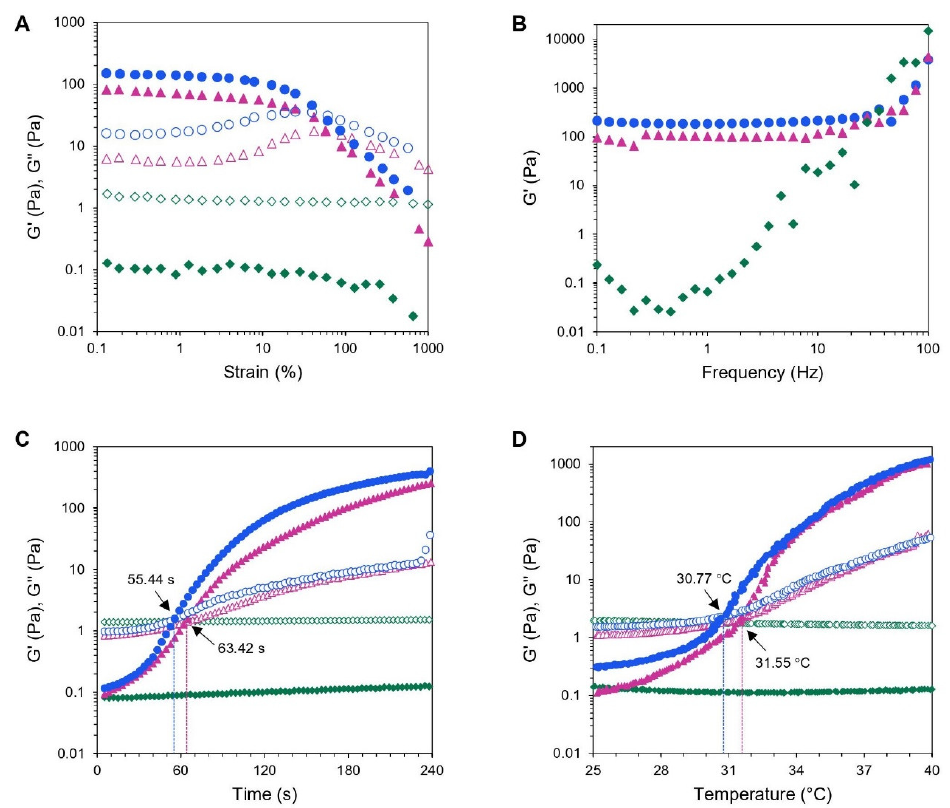
Figure 6. Rheological measurements of CS/PL-based hydrogels: amplitude strain sweeps ( A ), frequency sweeps ( B ), time sweeps ( C ), and temperature sweeps ( D ). Storage moduli and loss moduli (G’, G’’) of CS/PL ( , ), CS/PL/BGP ( , ), and CS/PL/BGP/GE ( , ).